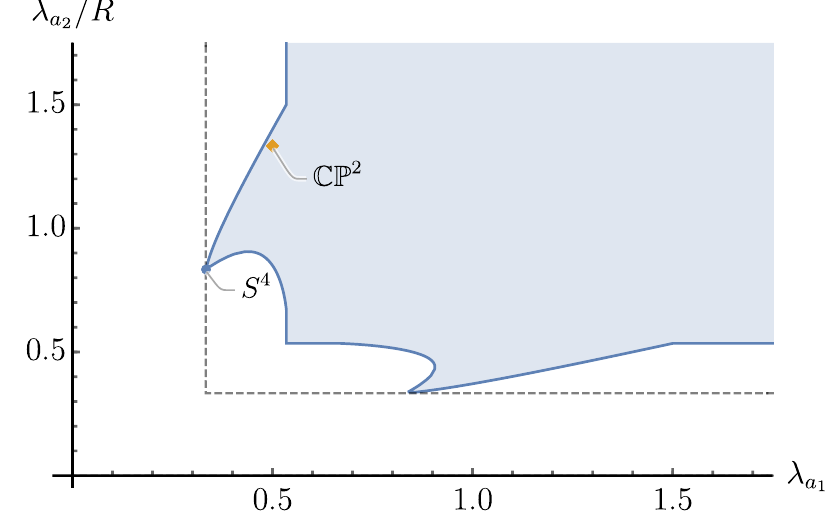
Figure 5 . The blue region shows the allowed values of the two smallest nonzero eigenvalues of the scalar Laplacian on closed four-dimensional Einstein manifolds with R > 0, assuming the eigenvalues satisfy the conditions in eq. (3.6). The dashed line is the Lichnerowicz bound and the points corresponding to S 4 and CP 2 with their standard metrics are